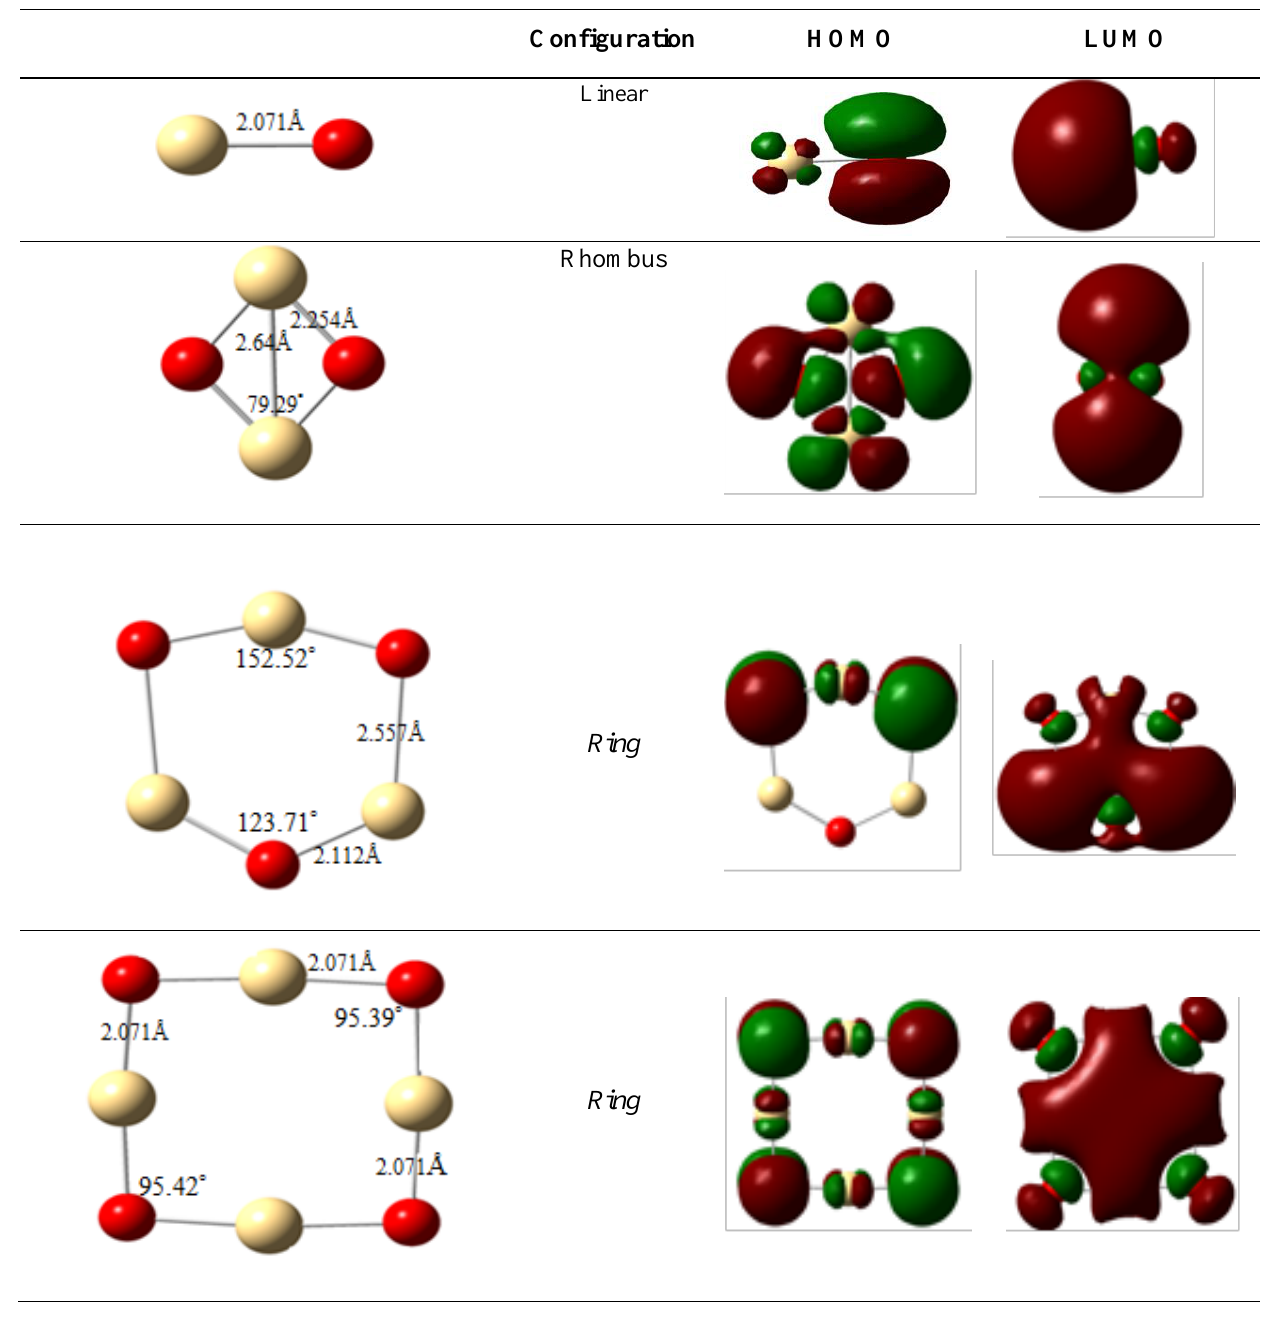
Fig. 1. Minimum energy structures and HOMO, LUMO pictures of (CdO)